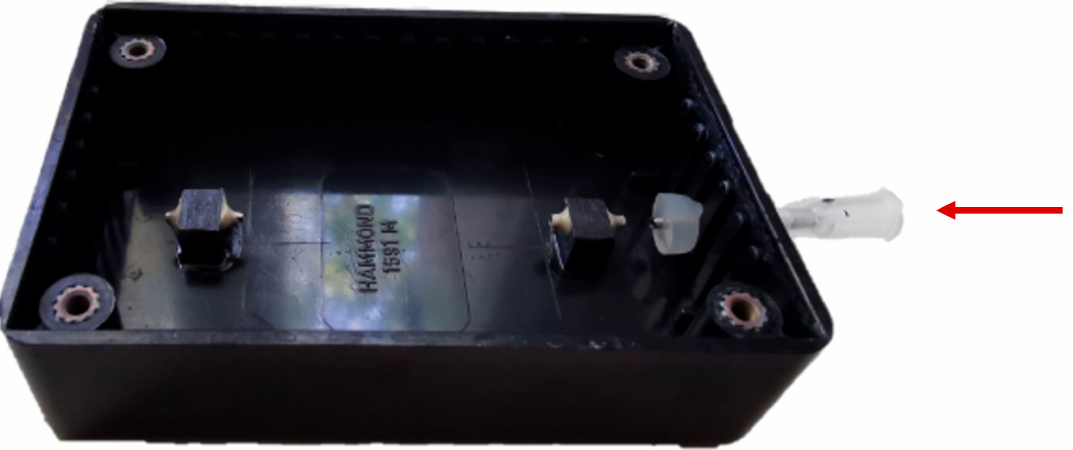
Figure 5. The wet chamber enables an analysis of the BMProbe™ under wet conditions. The BMProbe™ is held in a horizontal position. This supports a continuous analysis of the surface in focus. The black color absorbs the light so that there are no reflections. The BMProbe™ is inserted where the red arrow is